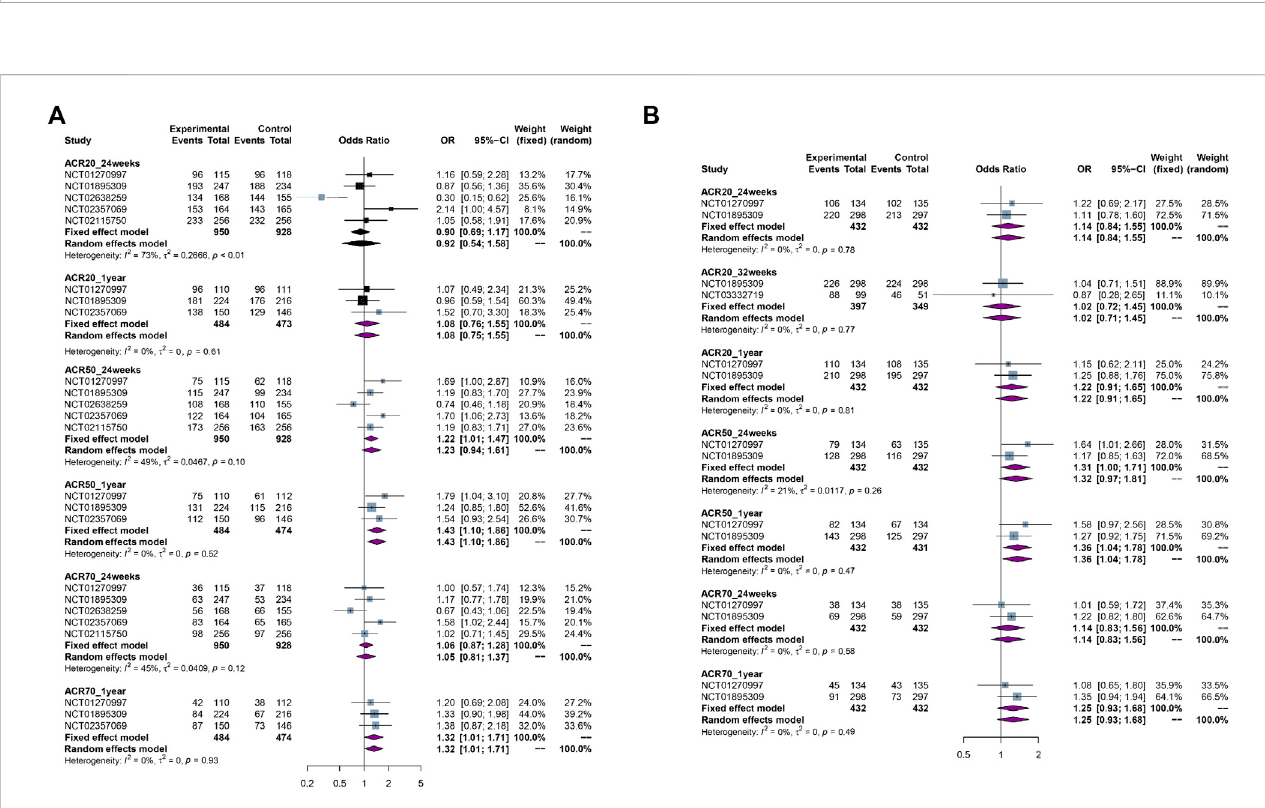
FIGURE 3 The forest plots ofef fi cacy assessment. (A) ACR20,ACR50,ACR70 response rate fromper-protocol set(PPS) atdifferenttime points. (B) ACR20,ACR50, ACR70 response rate from per-protocol set (PPS) at different time